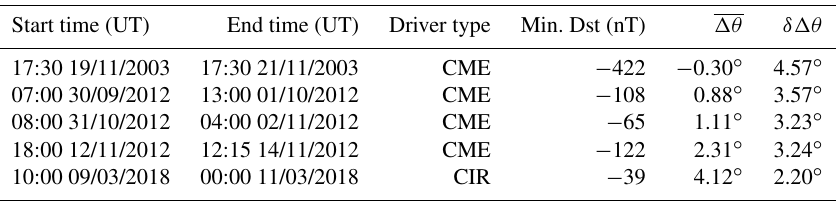
Table 1. List of the modeled storms with the mean and standard deviation of the differences in OCB latitude between the DMSP and OpenGGCM results. The second to last column is the mean model bias, where positive values indicate that the model on average predicts a lower latitude of the OCB, and the last column is the variance of the difference between the data and the model prediction.